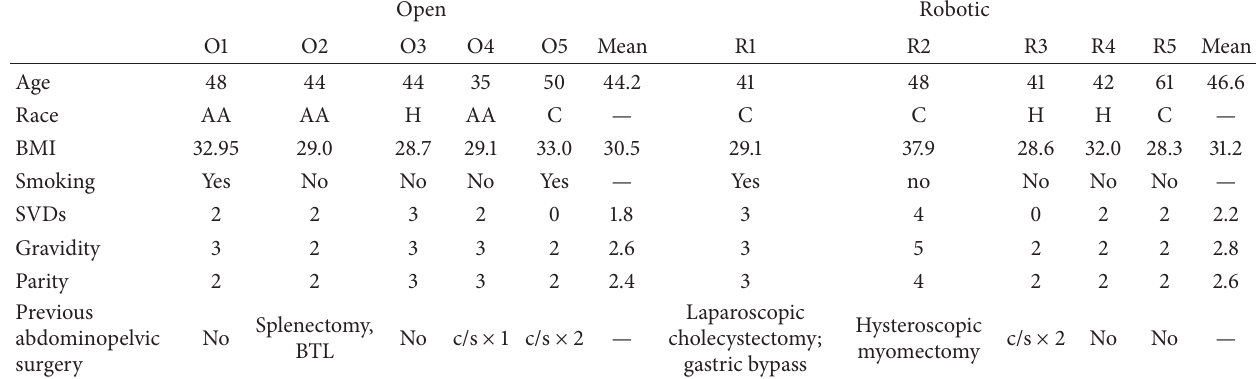
Table 1: Demographic information for each retropubic urethropexy